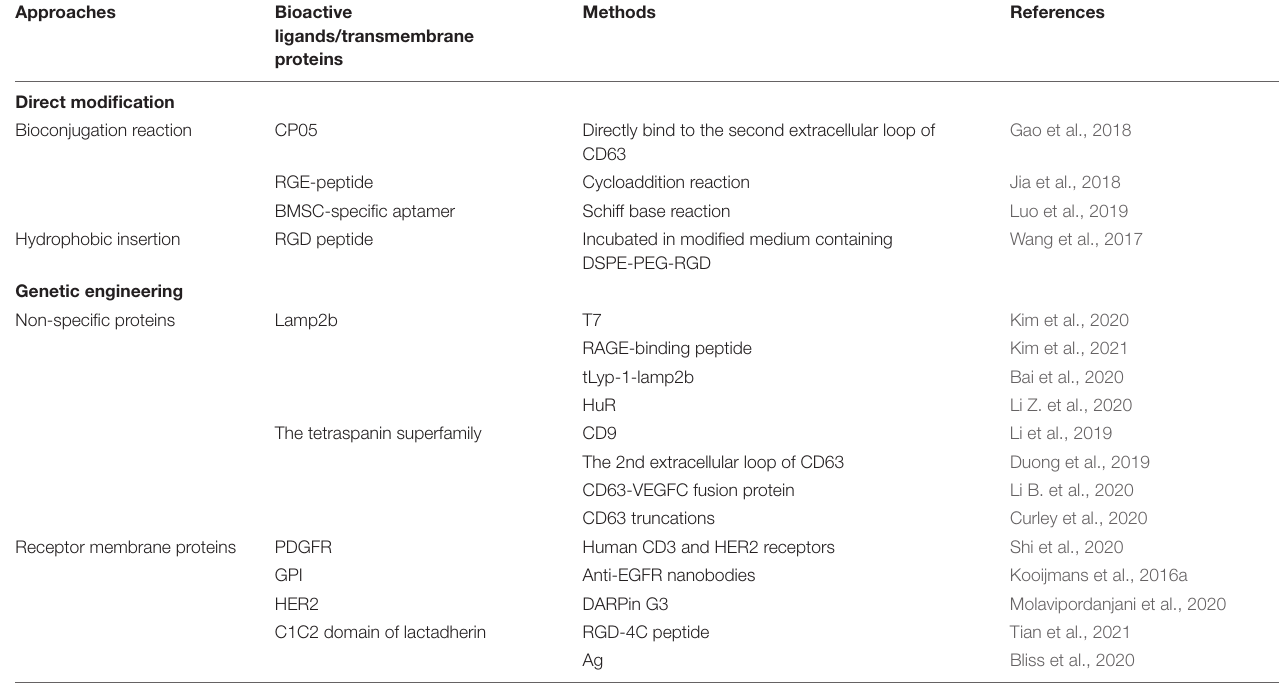
TABLE 2 | Exosome modification approaches for targeted